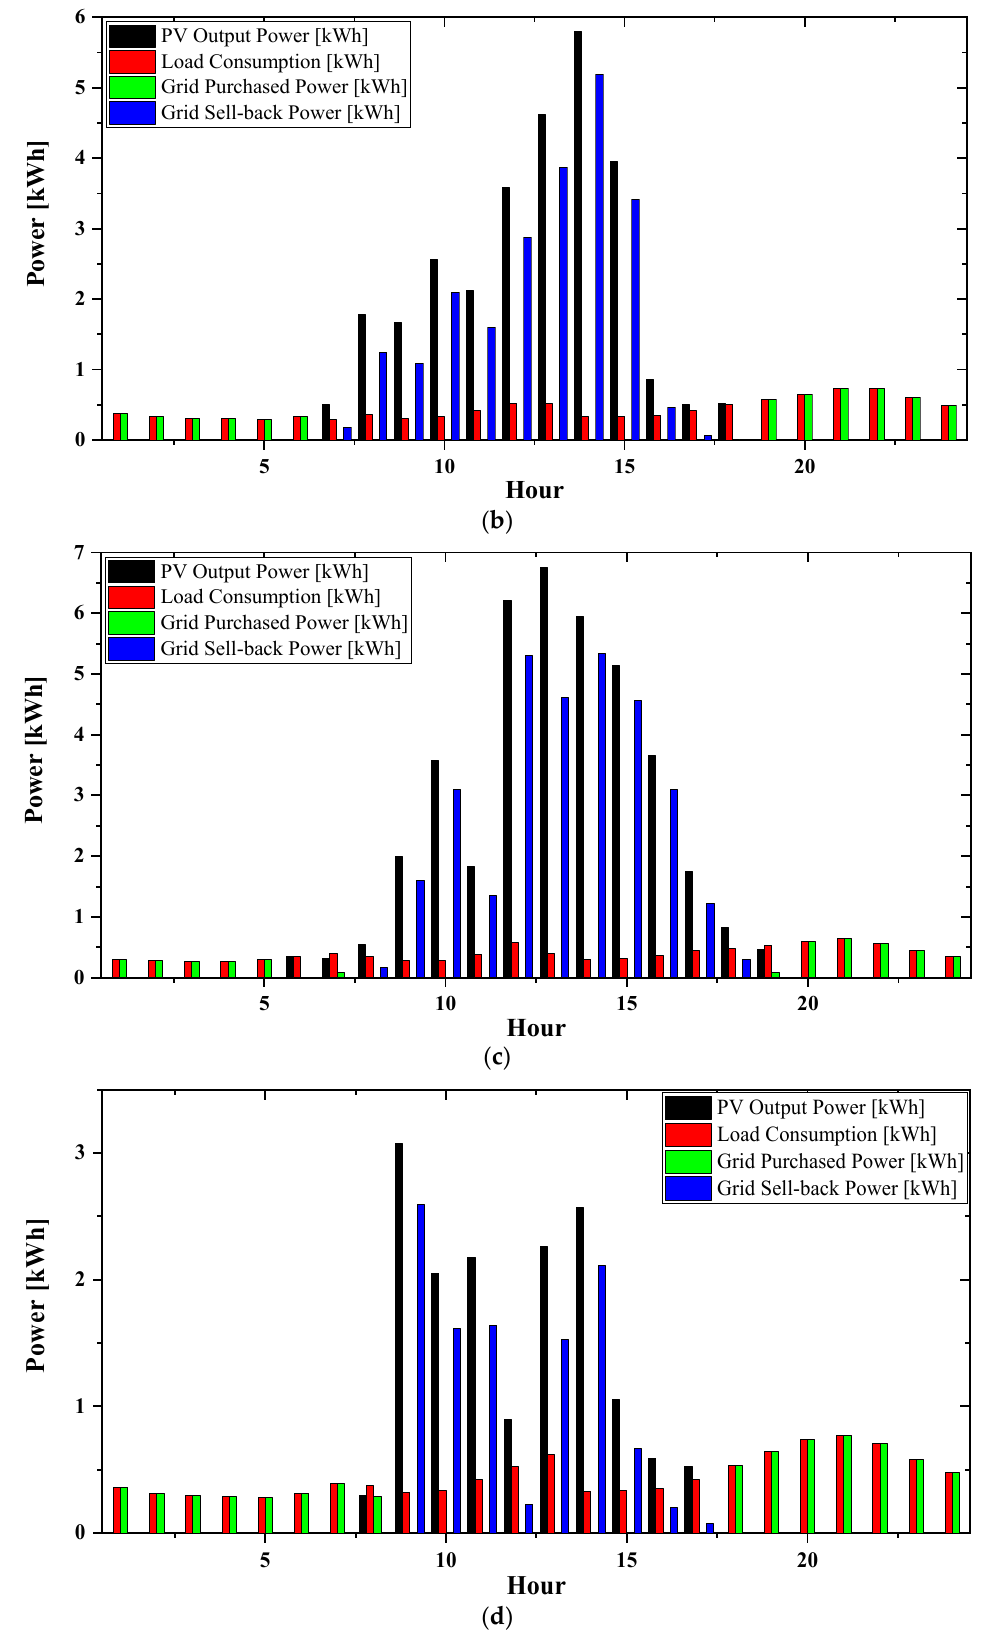
Figure 14. TOU-based operation results of the MG for ( a ) winter day; ( b ) spring day; ( c ) summer day; ( d ) fall day.